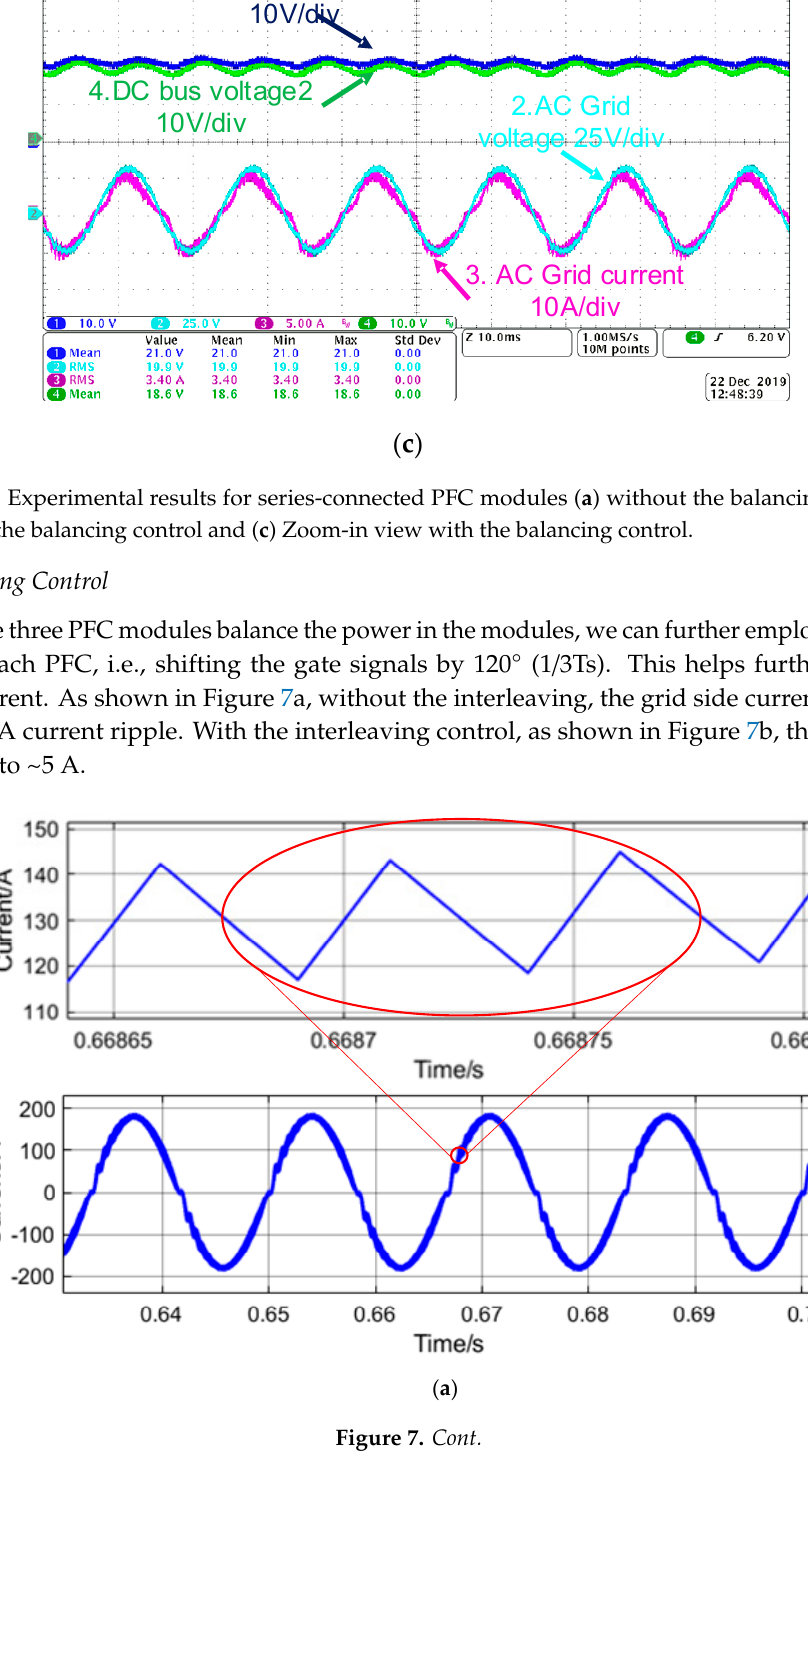
( b ) Figure 7. Simulated grid current ( a ) with same gate signal and ( b ) with interleaving gate signal. 3. DCX Stage Control 3.1. Power Balancing Control The DCX converter topology, as seen in Figure 1a, consists of a MOSFET half-bridge converter on the primary side, a three-winding MV transformer, a resonant capacitor and a MOSFET full-bridge converter on each secondary side. The primary-side and secondary-side MOSFETs share the same complementary PWM gate signals with 50% duty cycle. The relationship of the resonant frequency f r and the resonant parameters can be expressed by Equation (4), where L r is the leakage inductance of the transformer and C r represents the capacitance of the resonant capacitor.